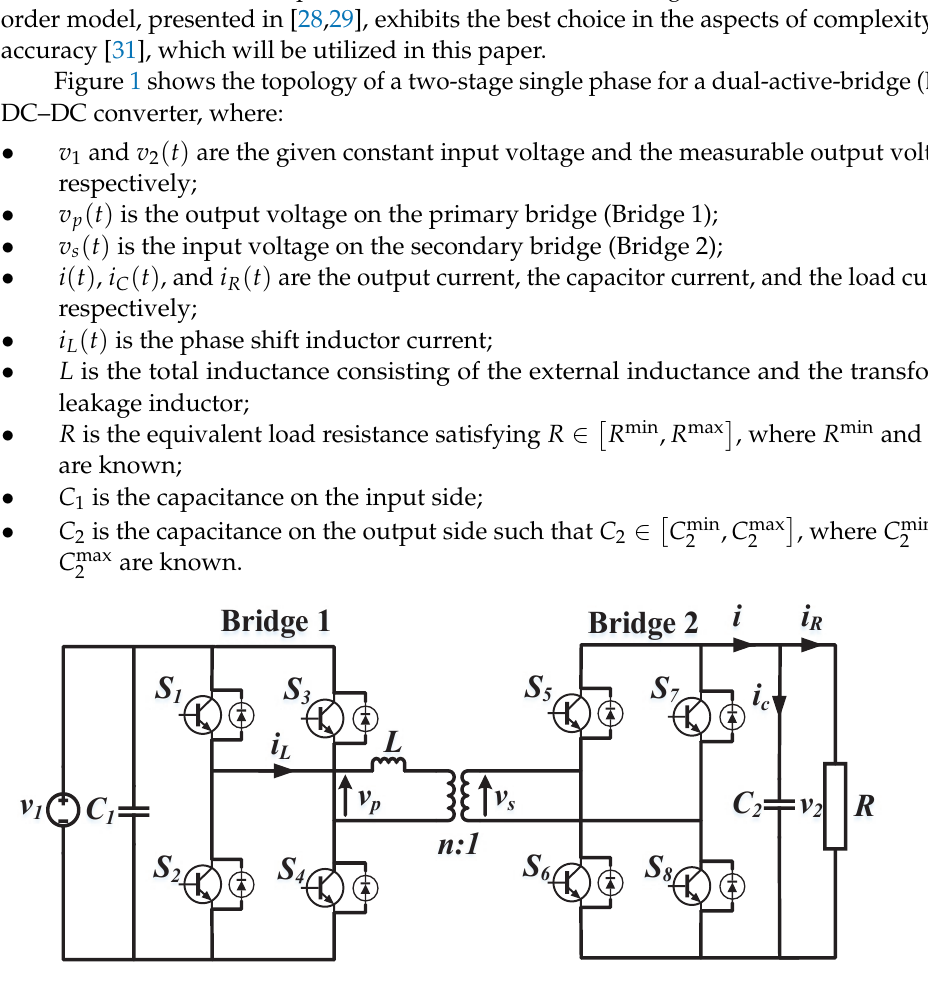
Figure 1. The topology of a dual-active-bridge